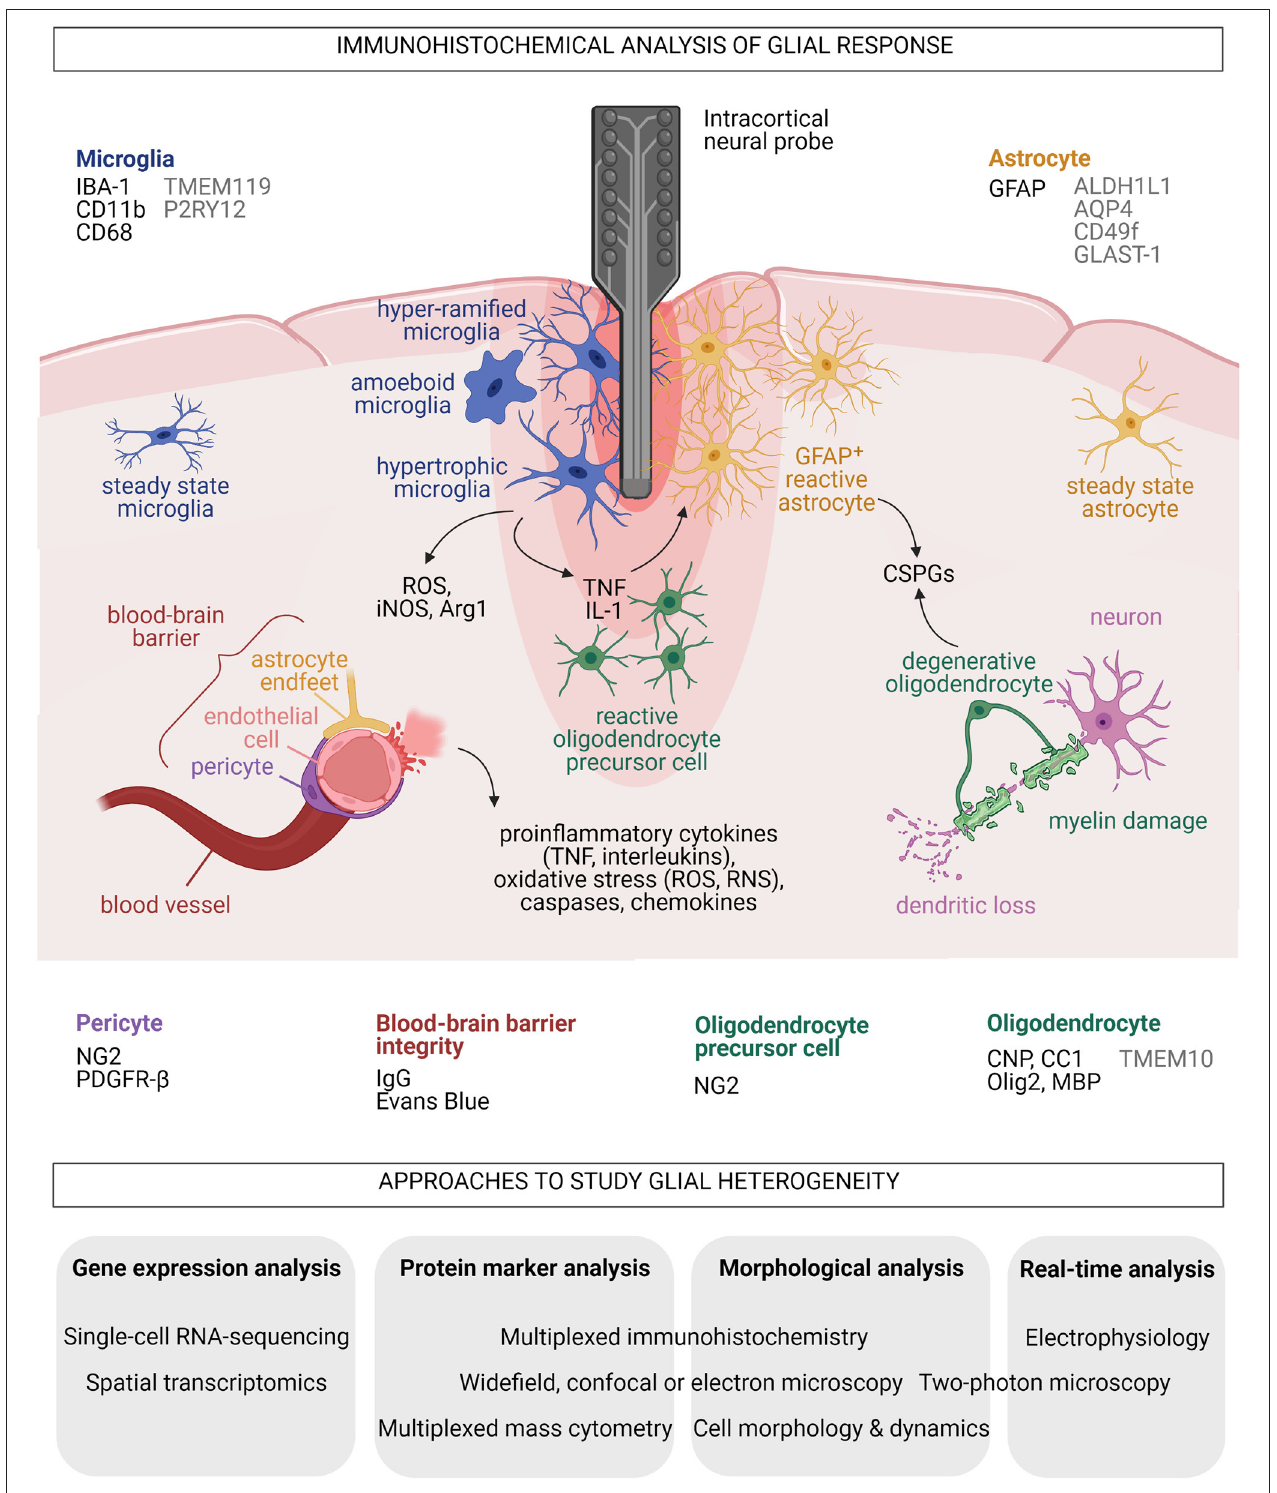
FIGURE 1 | Summary of acute glial responses to implantation of neural microprobes in the mammalian brain and proposed approaches to study glial heterogeneity. Common markers (black) and additional markers (gray) for histological analyses of each glial type and blood-brain barrier integrity around the implants are listed. Black arrows indicate secreted molecules. Created with